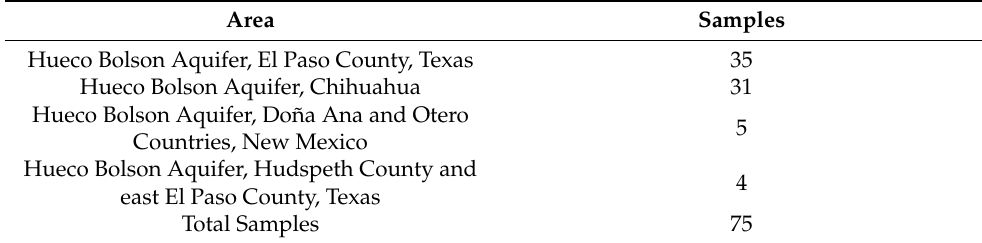
Table 2. Samples in Hueco Bolson Aquifer by Eastoe et al. (2007) [12]. Area